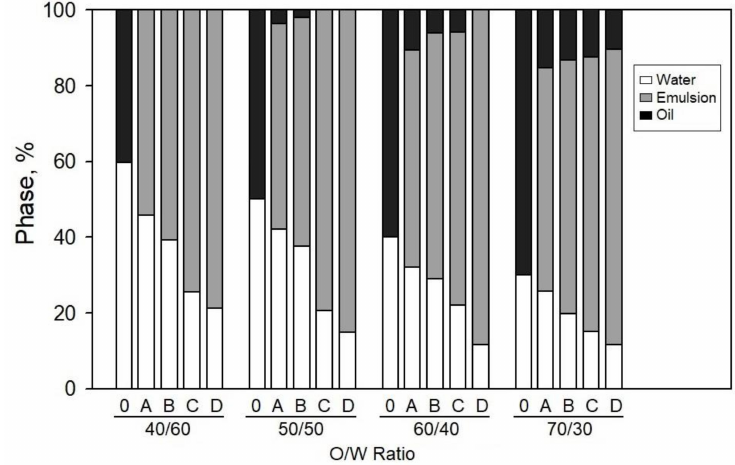
Figure 4. Stabilization over time results of different O/W emulsions after 48 h. (CMF dosages: 0: 0 wt%, A: 0.25 wt%, B: 0.50 wt%, C: 0.75 wt%, D: 1.00